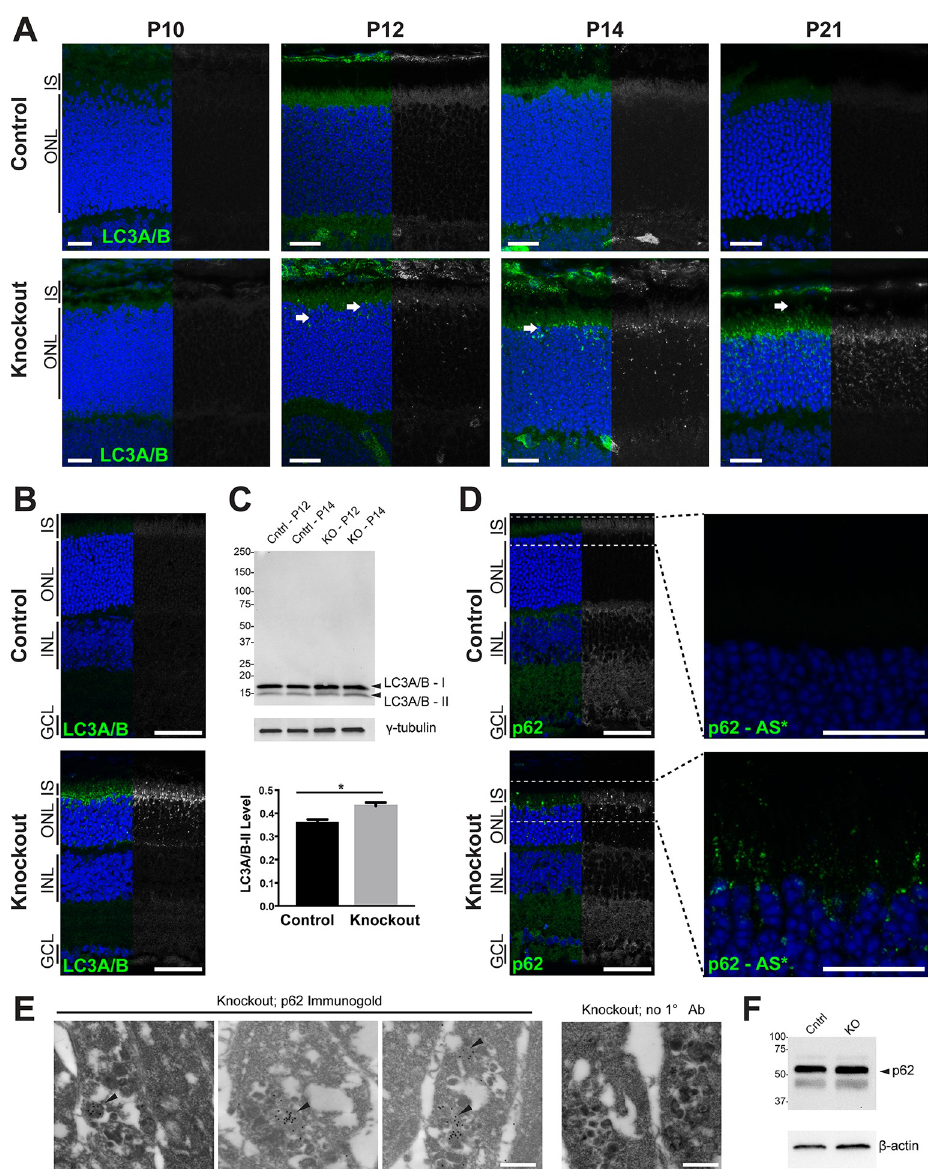
Fig 6. Loss of Rabgef1 leads to autophagy defects in the retinal photoreceptors. (A) Immunohistochemistry of control and Rabgef1 -/- retinas using anti-LC3A/B antibody. Retinal sections were counterstained with DAPI. Scale bar = 20 μ m. ONL, outer nuclear layer; IS, inner segment. (B) Low magnification images of anti-LC3A/B staining in P17 retina. Scale bar = 20 μ m. INL, inner nuclear layer; GCL, ganglion cell layer. (C) Immunoblot of P12 and 14 control and Rabgef1 -/- retinal lysates probed with antibody to LC3A/B (upper panel). Lower arrowhead indicates increase in the LC3A/B-II lipidated form in Rabgef1 -/- retinas. For quantification of LC3A/B-II level, P12 and P14 band intensities were combined and normalized to γ -tubulin (lower panel). (D) Left panels show low-magnification images of anti-p62 staining in P17 retina. Scale bar = 50 μ m. Right panels show the same sections imaged at high magnification using Airyscan (AS � ). Scale bar = 20 μ m. (E) Transmission electron micrographs of Rabgef1 -/- photoreceptor inner segments at P17 immunolabeled with anti-p62/immunogold or immunogold without primary antibody. Arrowheads indicate anti-p62 immunolabeling in electron-dense deposits. Scale bar = 500 nm. (F) Immunoblot of P14 control and Rabgef1 -/- retinal lysates probed with antibody to p62. β -actin was used as a loading